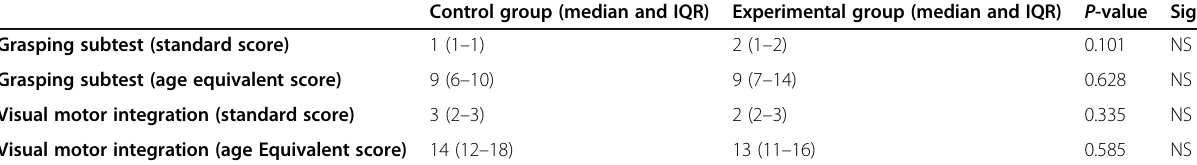
Table 1 Comparison of pre-treatment results of experimental and control groups Control group (median and IQR) Experimental group (median and IQR) P -value Sig. Grasping subtest (standard score) Visual motor integration (standard score)